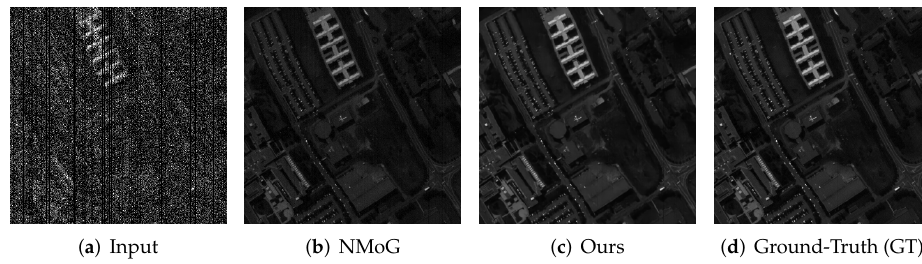
Figure 1. An evaluation between our algorithm and the state-of-the-art NMoG denoising method